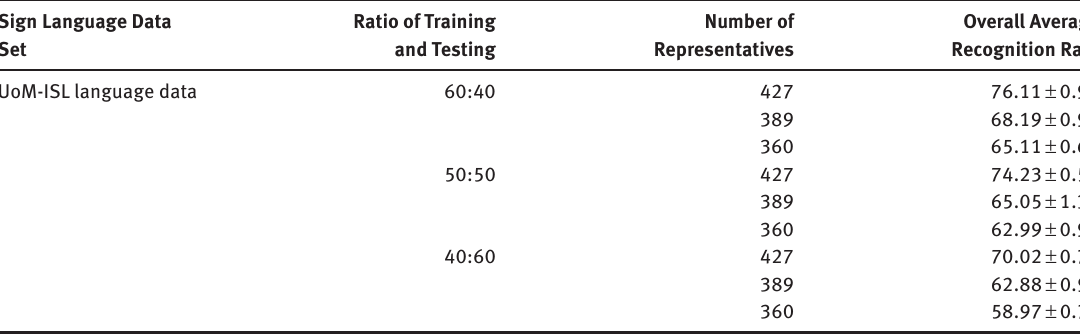
Table 4: Overall Average Recognition Performance of the Proposed Method in Terms of F-measure using LBP Features for Differ- ent Percentages of Training and Testing.